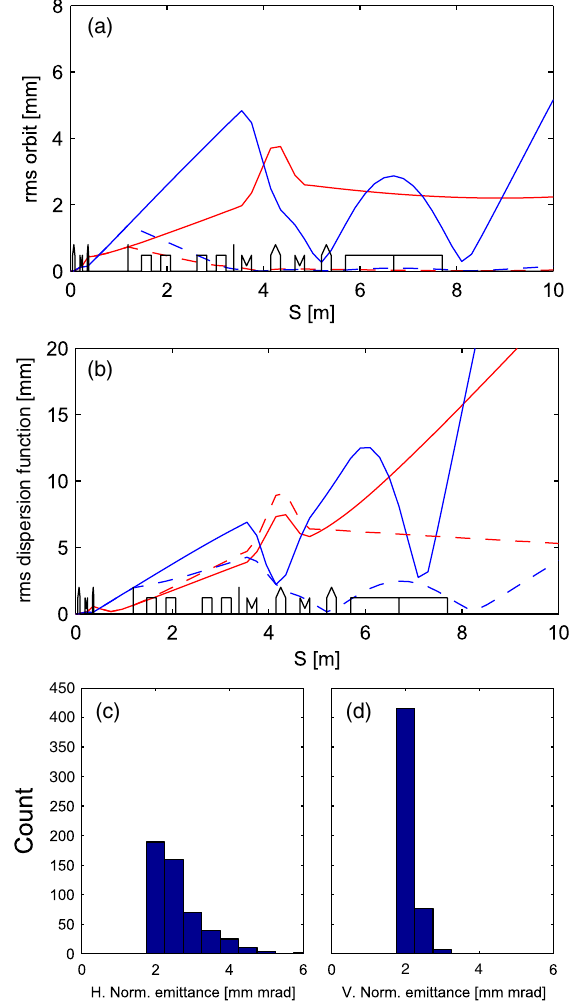
FIG. 13. Effect of random magnet misalignments/defaults on the electron beam (a) rms orbits and (b) rms dispersion functions, in the (red) horizontal and (blue) vertical plane, (line) without and (dashed line) with orbit correction. (c – d) Effect on the statistical normalized emittance distribution in the horizontal and vertical plane (500 tries) with orbit correction. Initial undisturbed emittances are about 2 π mm mrad in both planes. (a – b) Random displacement of all the quadrupoles magnetic center by up to 100 μ m, together with a random tilt of the dipoles of up to 1 mrad and a random error on their possible relative strength of up to 0.1%. (c – d) Random displacement of all the quadrupoles only. Beam transport simulation in the nonlinear case with BETA and sympletic 6D tracking without collective effects using the S2I- CM optics with r 11 ¼ r 33 ¼ 10 and r 56 ¼ 0 . 4